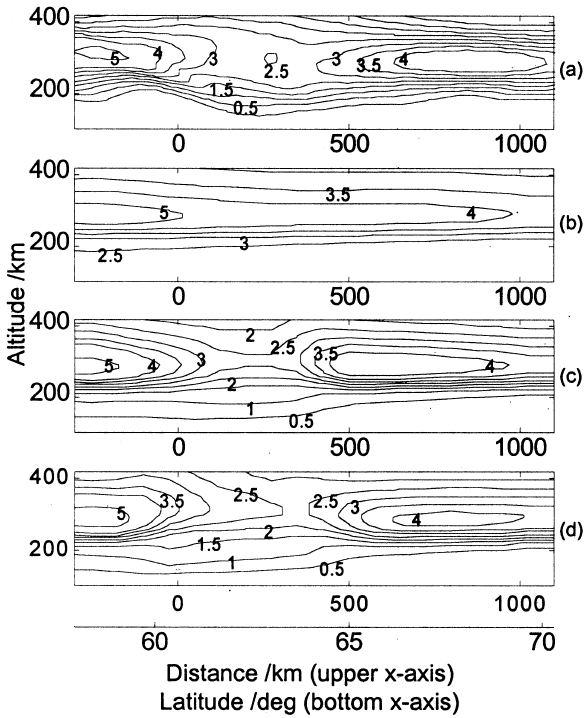
Fig. 1. Contour patterns of the daytime electron density ( × 10 11 m − 3 ) observed in the vertical plane over the chain of receivers in Scandinavia at 10:12 UT on 17 November 1995. (a) Experimental reconstructed image obtained by means of stochastic tomographic inversion. (b) Model pattern obtained by excluding the electric field and particle precipitation. (c) Model pattern obtained by including an inhomogeneous meridional electric field but no particle precipi- tation. (d) Model pattern obtained by including both an inhomoge- neous electric field and precipitation of soft electrons.